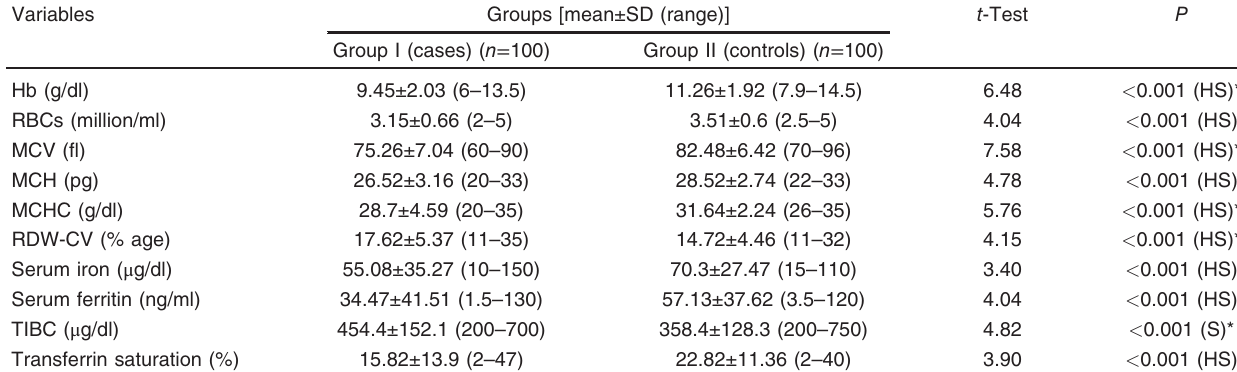
Table 2 Laboratory parameters of anemia in group I (cases) and group II (controls) Variables Groups [mean±SD